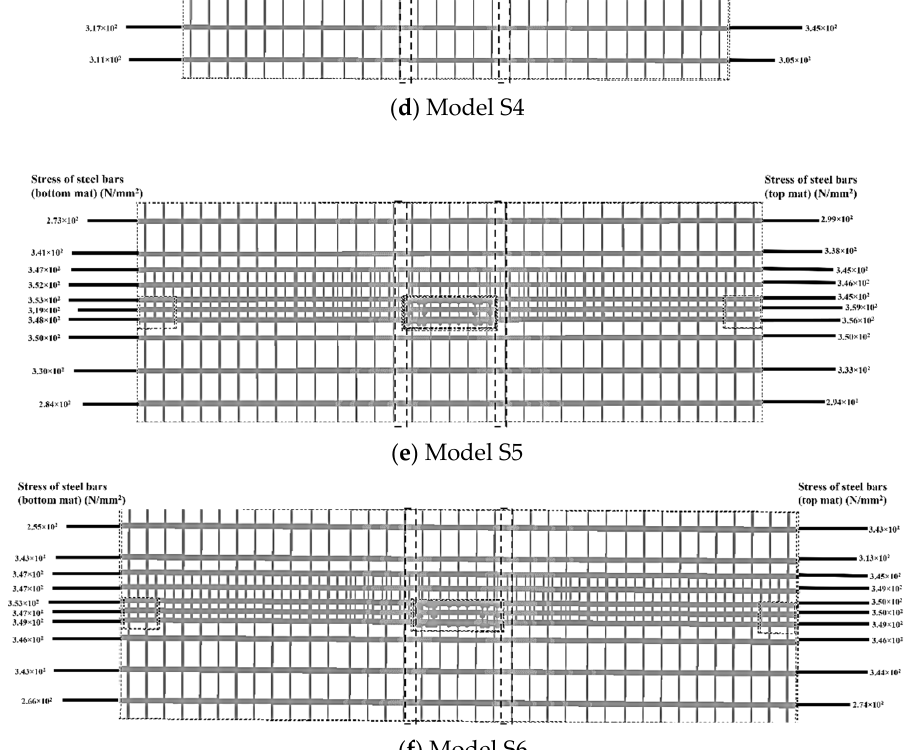
107.06 Figure 22. Simulation flexural strength versus calculated flexural strength for slab span length mod- els. 4.2. Slab Width Nine models with different values of slab width ranging from 350 mm to 1850 mm were established to discuss the effect on the slab flexural behavior. Figure 23 shows the